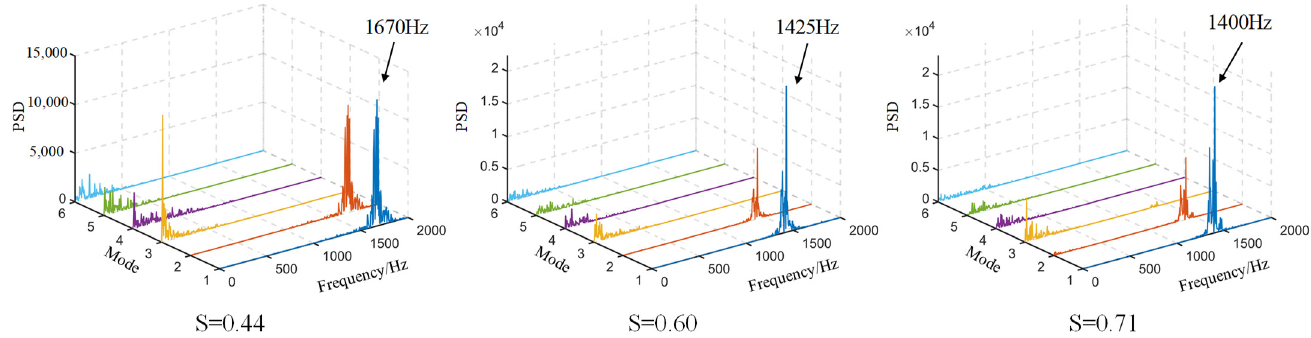
Figure 11. PSD of POD under different flow field snapshots.